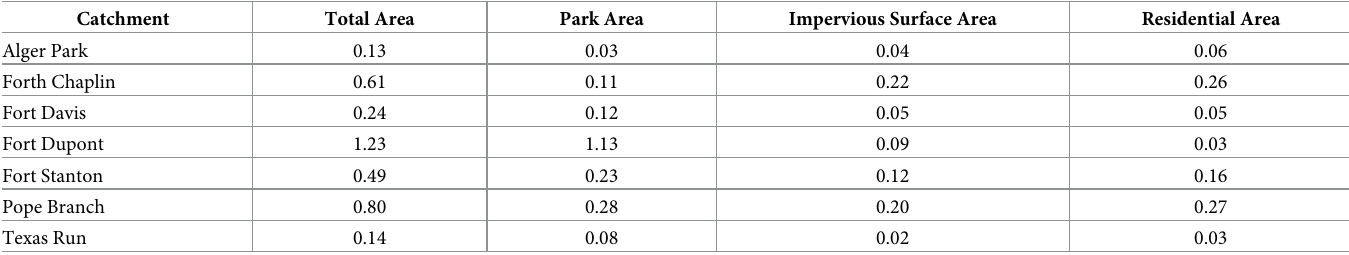
Table 1. Summary of land use measurements (km 2 ) for each catchment.